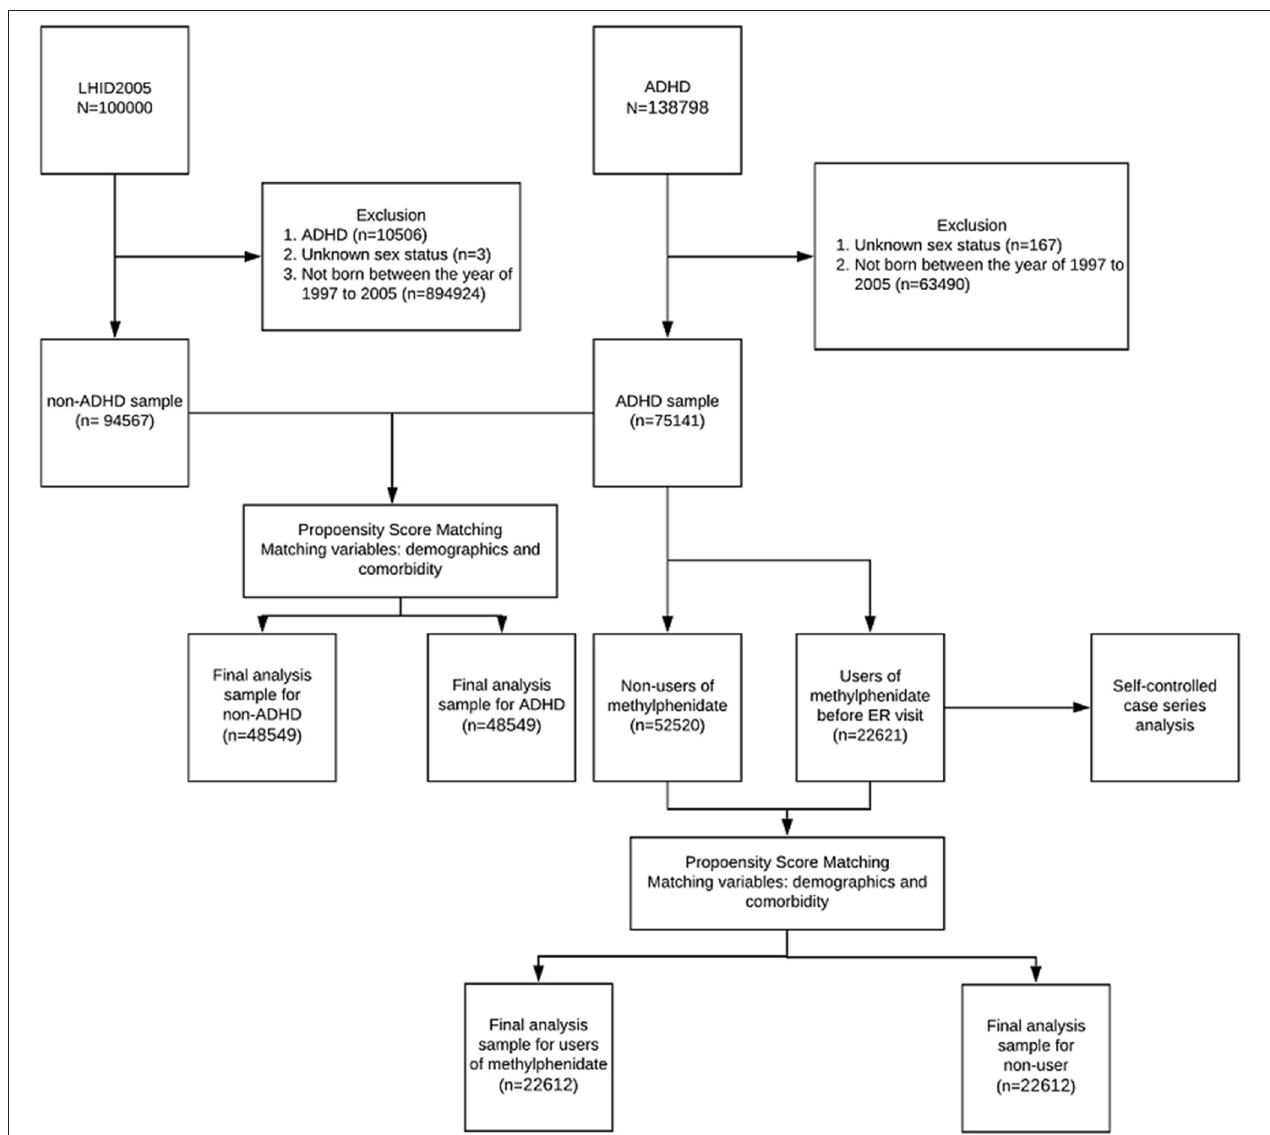
FIGURE 1 | The flow chart for selections, propensity score-matching, and self controlled case series comparisons among our study subjects.